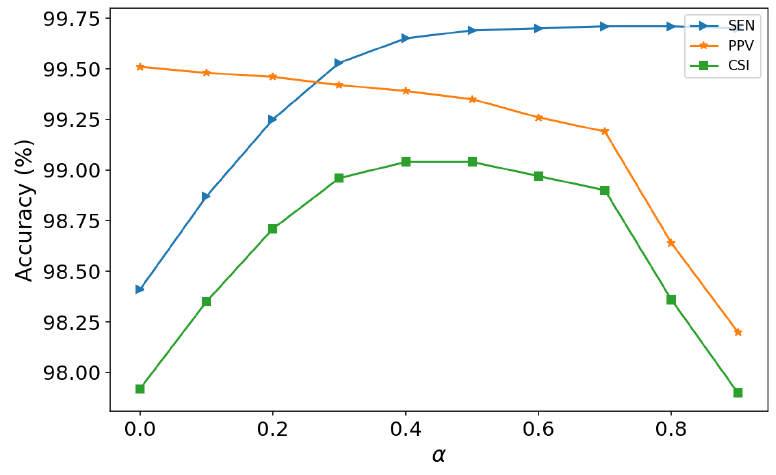
Figure 8. The performance with different α for SEN (sensitivity), PPV (positive predicative value) and CSI (cumulative statistical index). P wave—Indicates atrial depolarization, or contraction of the atrium; QRS complex—Indicates ventricular depolarization, or contraction of the ventricles; T wave—Indicates ventricular